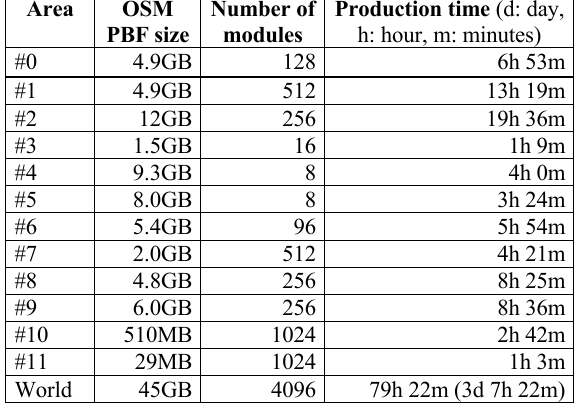
Table 2. Production time of global vector tiles divided by